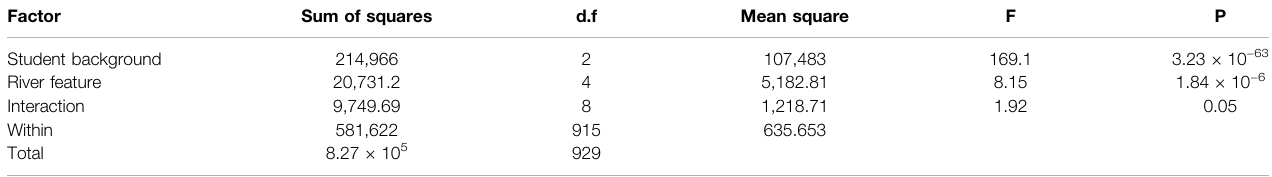
TABLE 1 | Two-way ANOVA showing the weight of student ’ s background and the river feature in the willingness to pay for river ecosystem improvement. Factor Sum of squares d.f Mean square F P